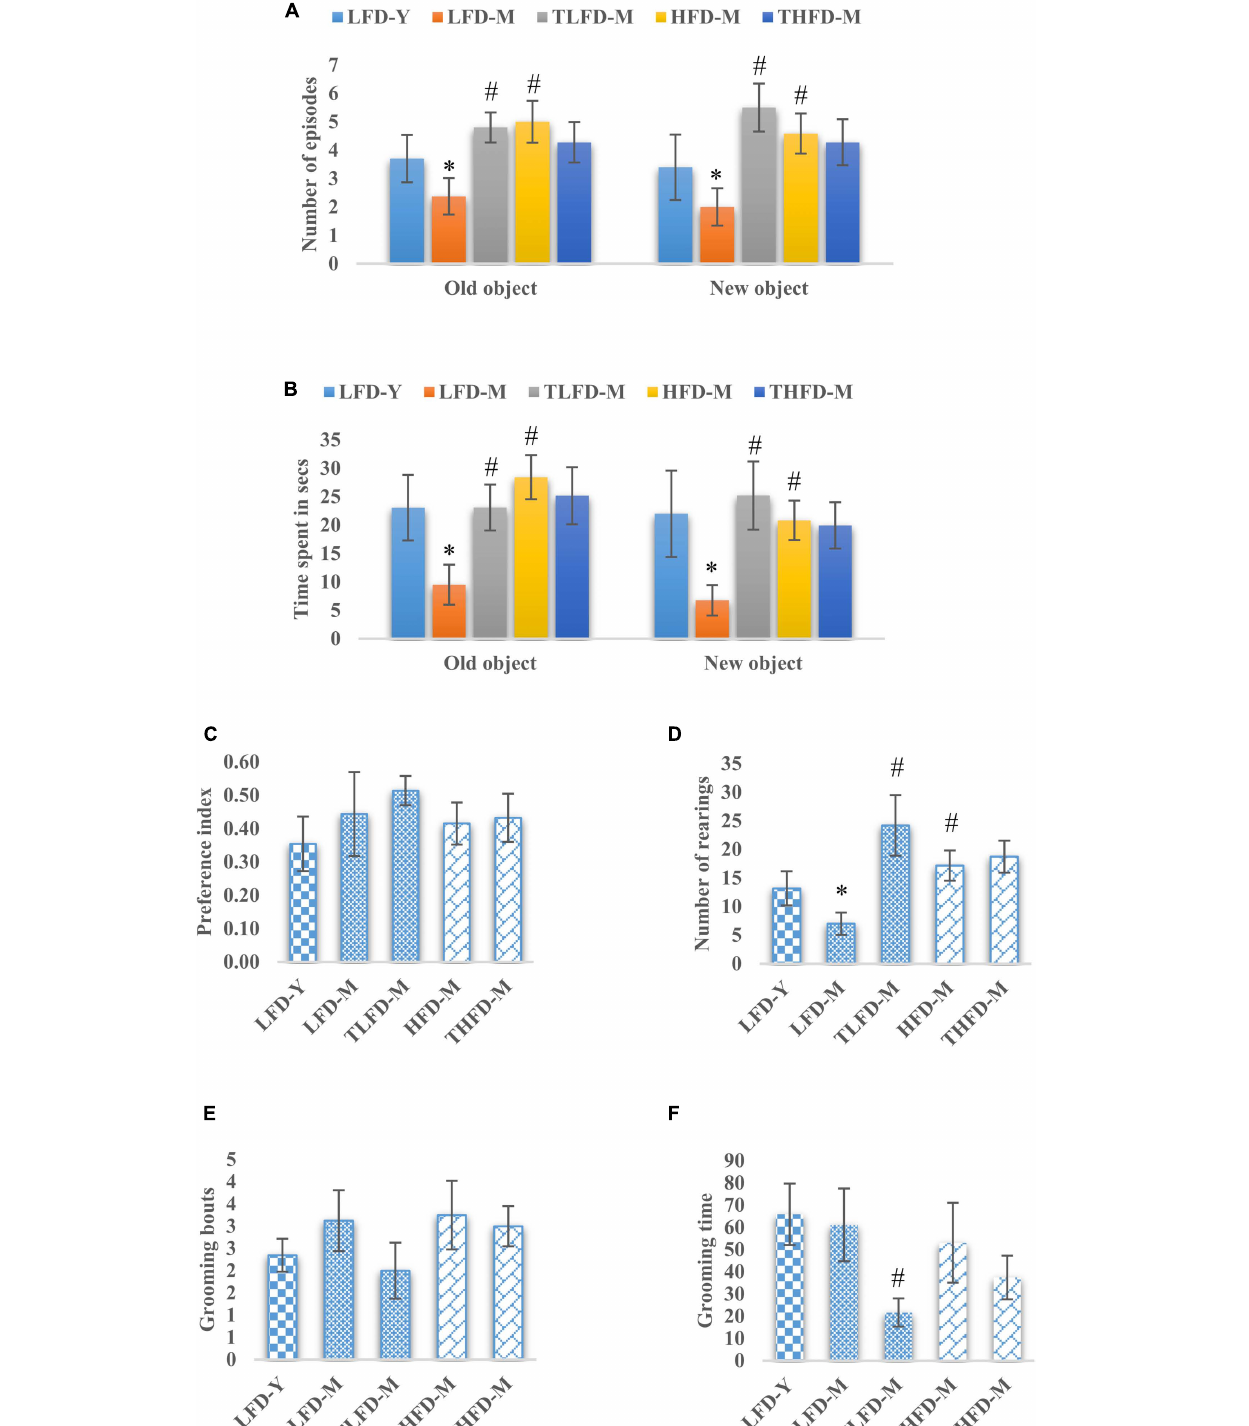
Frontiers in Aging Neuroscience |